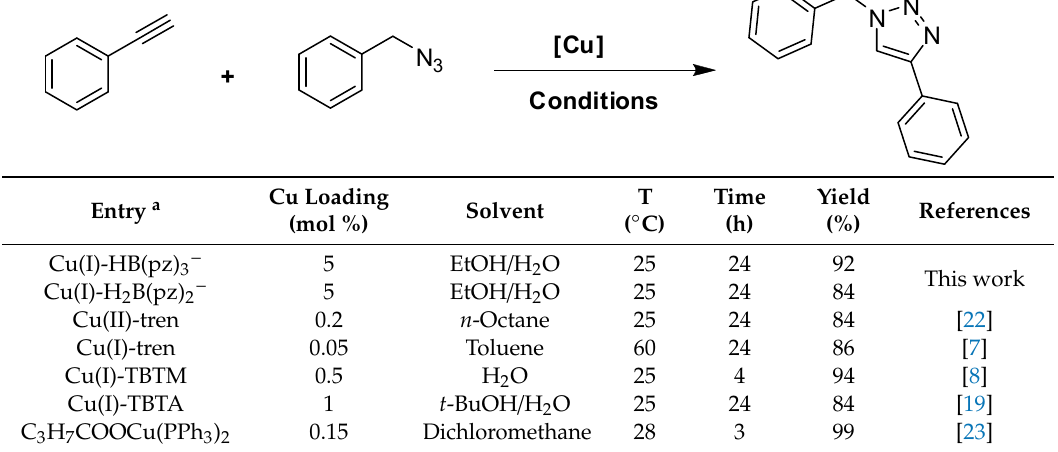
Table 4. Catalytic performance of poly(pyrazolyl)borate-copper(I) systems with other literature reports in CuAAC reactions.